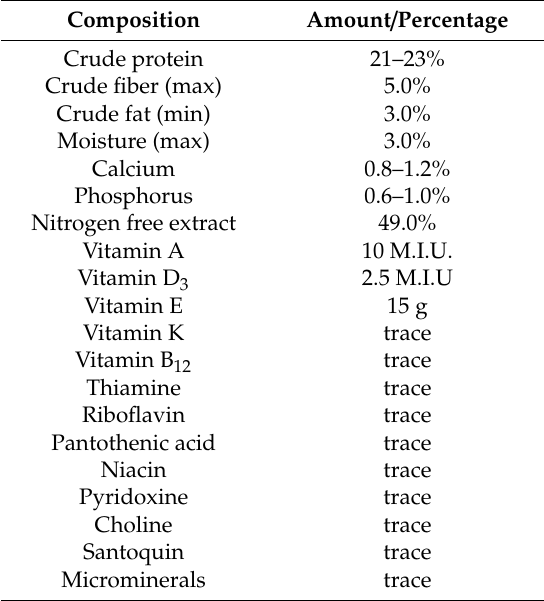
Table 1. Composition of rat chow (Gold coin Malaysia) used for the feeding of the rats [21].